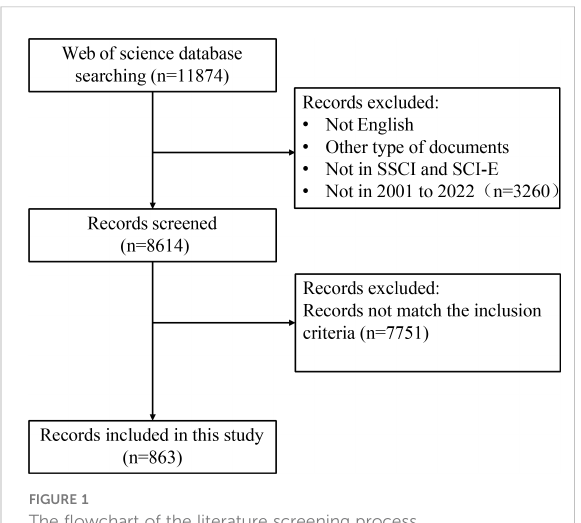
FIGURE 1 The fl owchart of the literature screening